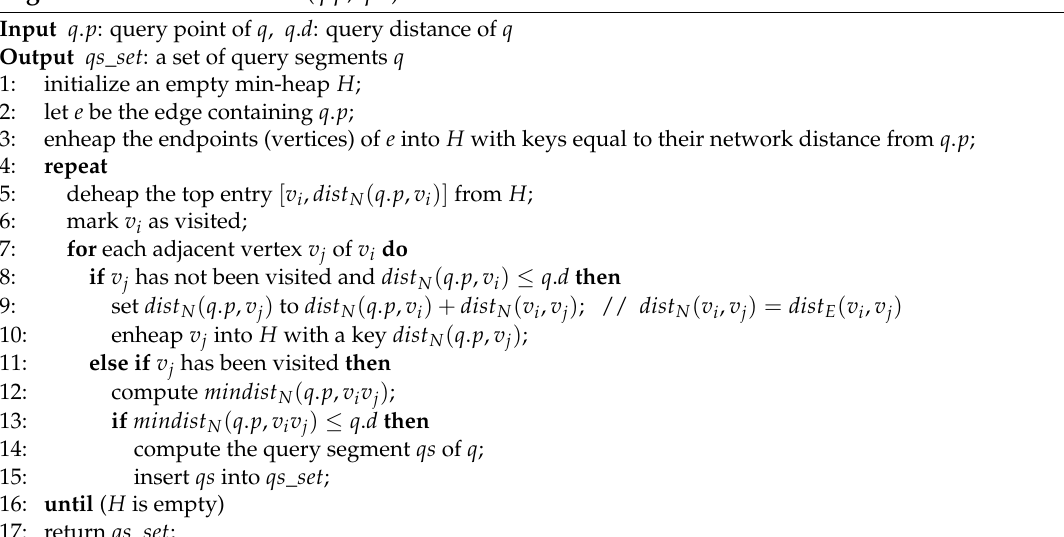
Algorithm 1 C OMPUTE S EG ( q . p , q . d